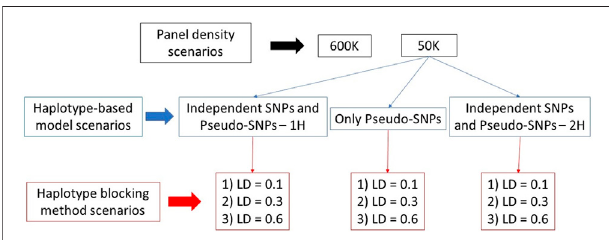
FIGURE 2 | Evaluated scenarios used in the genomic predictions with pseudo-single nucleotide polymorphisms (SNPs) from linkage disequilibrium (LD) blocks using independent and pseudo-SNPs in a single genomic relationship matrix (1H), and only pseudo-SNPs and independent and pseudo SNPs in two genomic relationship matrices